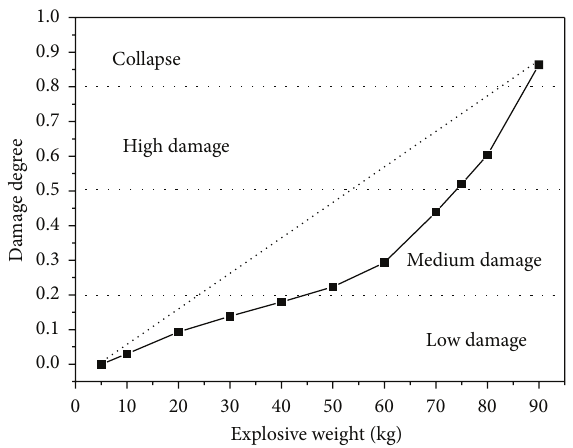
Figure 13: Damage degree of RC slabs under different explosive weights. Figure 14: Damage degree of RC slabs under different explosive